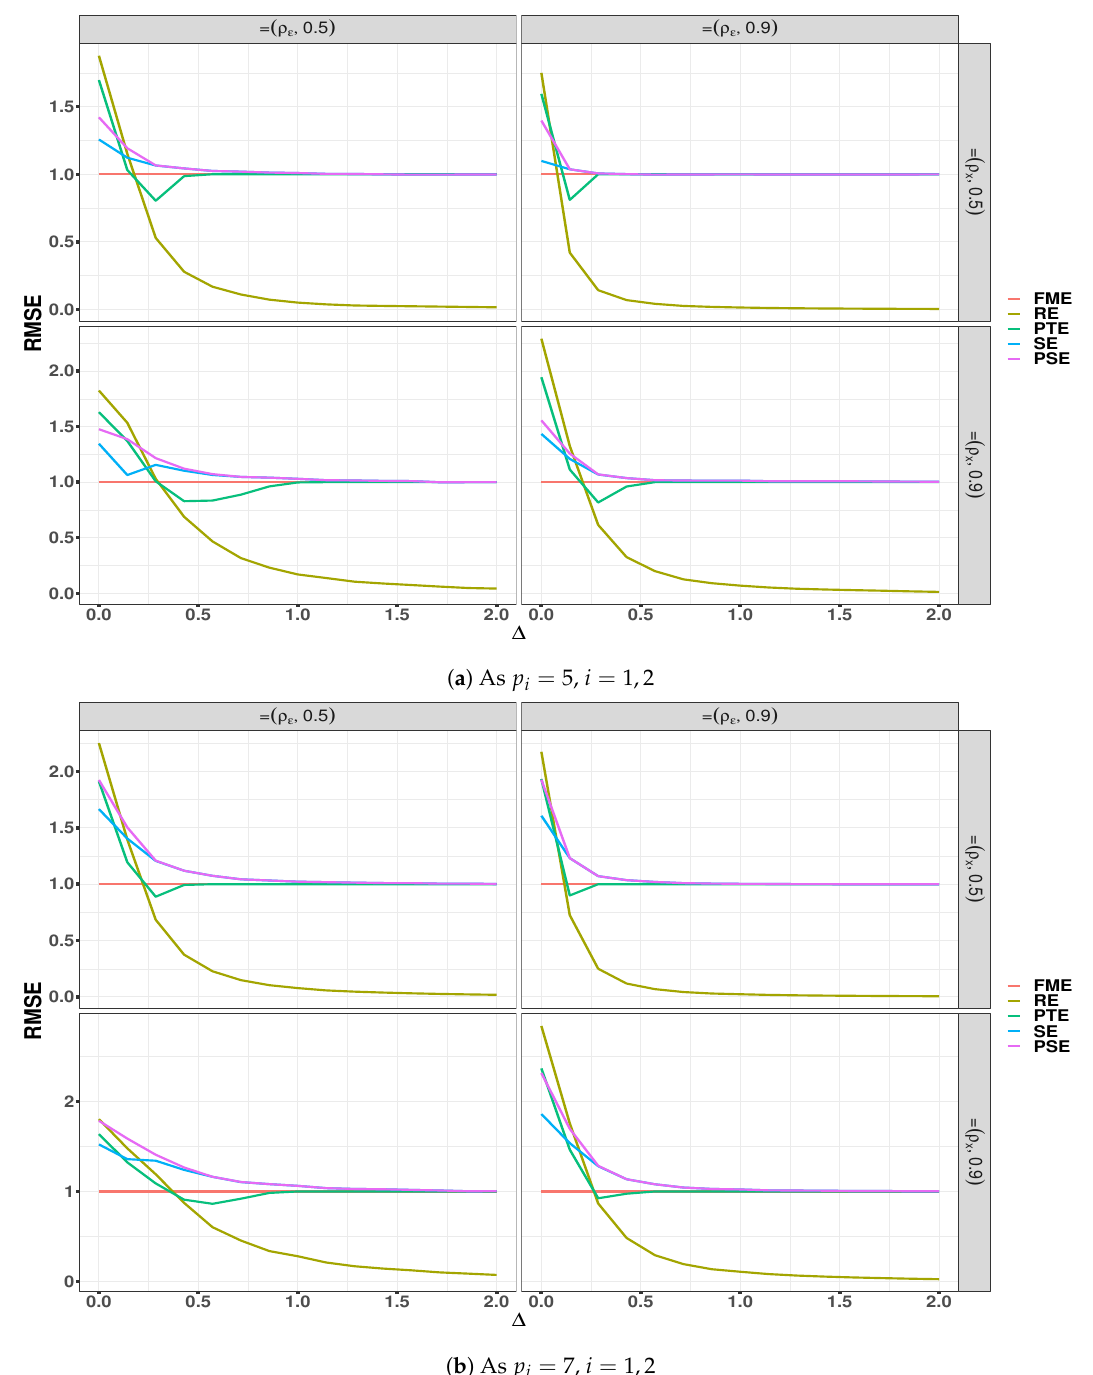
Figure 1. RMSE of the estimators as a function of ∆ when M = 2, T = 100, ρ x = 0.5,0.9, and ρ ε = 0.5,0.9. FME, full model estimator; RE, restricted estimation; PTE, preliminary test estimator; PSE, positive-rule Stein-type